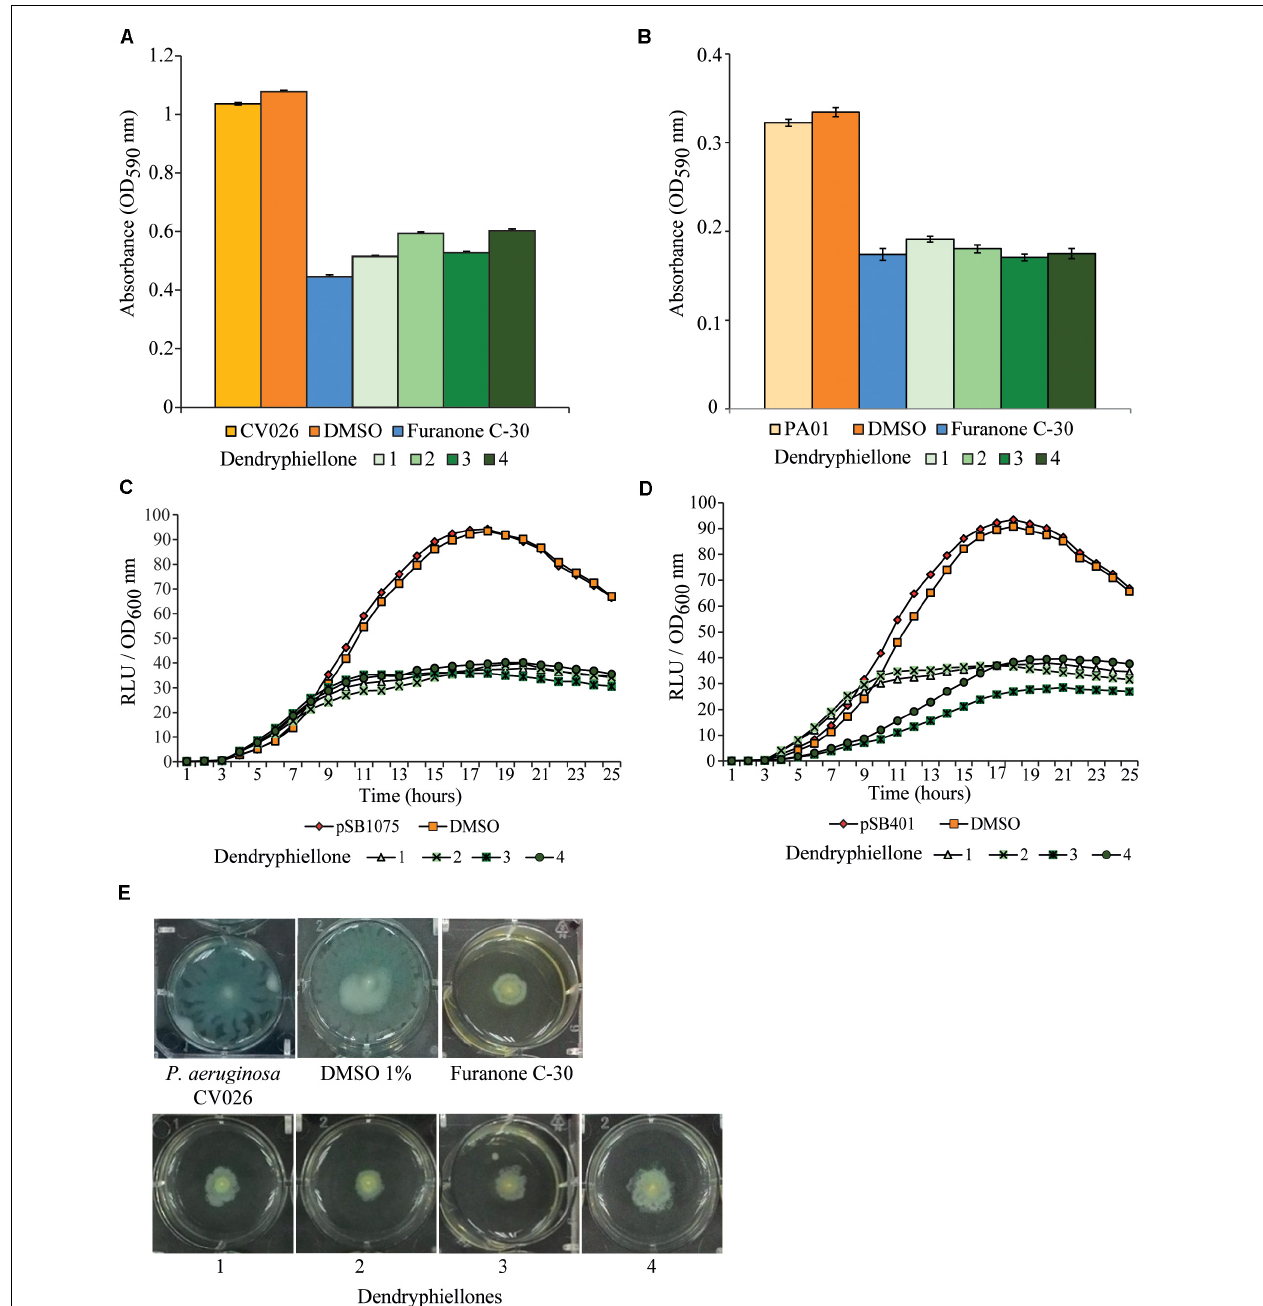
FIGURE 2 | Functional bioassays attesting of the quorum quenching abilities the dendryphiellones 1-4 . (A) Inhibition of violacein production in C. violaceum CV026 in the presence of the four compounds. (B) Effects of the compounds against the production of pyocyanin in P. aeruginosa PAO1. (C) Inhibition of lux -based biosensors by the compounds 1-4 in E. coli [pSB401] and (D) E. coli [pSB1075]. (E) Swarming assays against P. aeruginosa PAO1 (1) supplemented with 1% ( v/v ) DMSO and 15 µ g mL - 1 of (3) furanone C-30, (4) dendryphiellone A, (5) dendryphiellone B, (6) dendryphiellone C, and (7) dendryphiellone D.